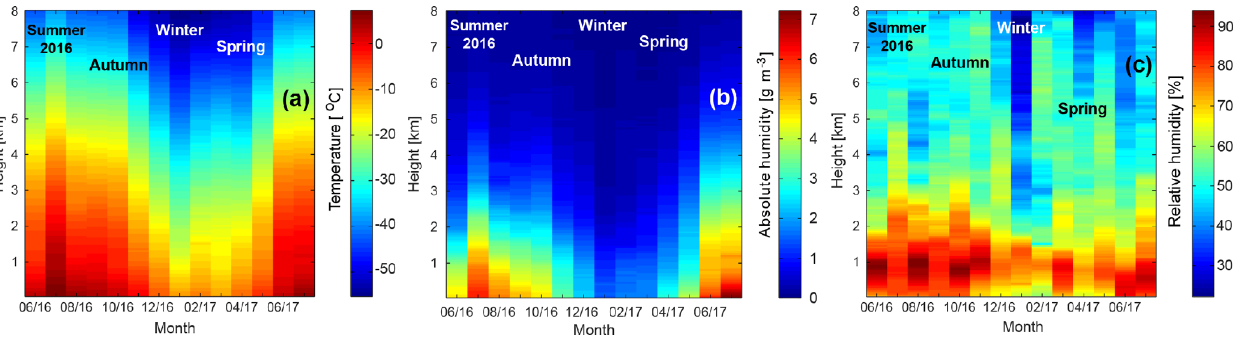
Figure 5. Vertical profiles of monthly mean atmospheric temperature (a) and absolute (b) and relative humidity (c) from radiosonde obser- vations at Ny-Ålesund from June 2016 to July